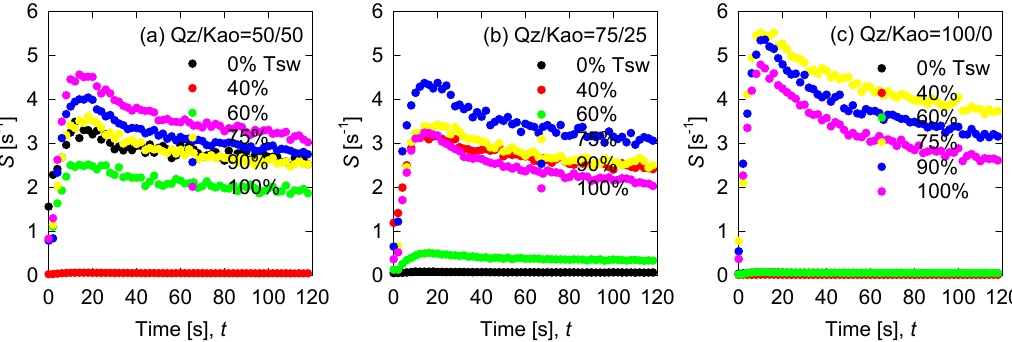
Figure 7. Breakage rate for the mean chord length over time. Quartz / Kaolinite ratio ( a ) 50 / 50; ( b ) 75 / 25; ( c ) 100 / 0.